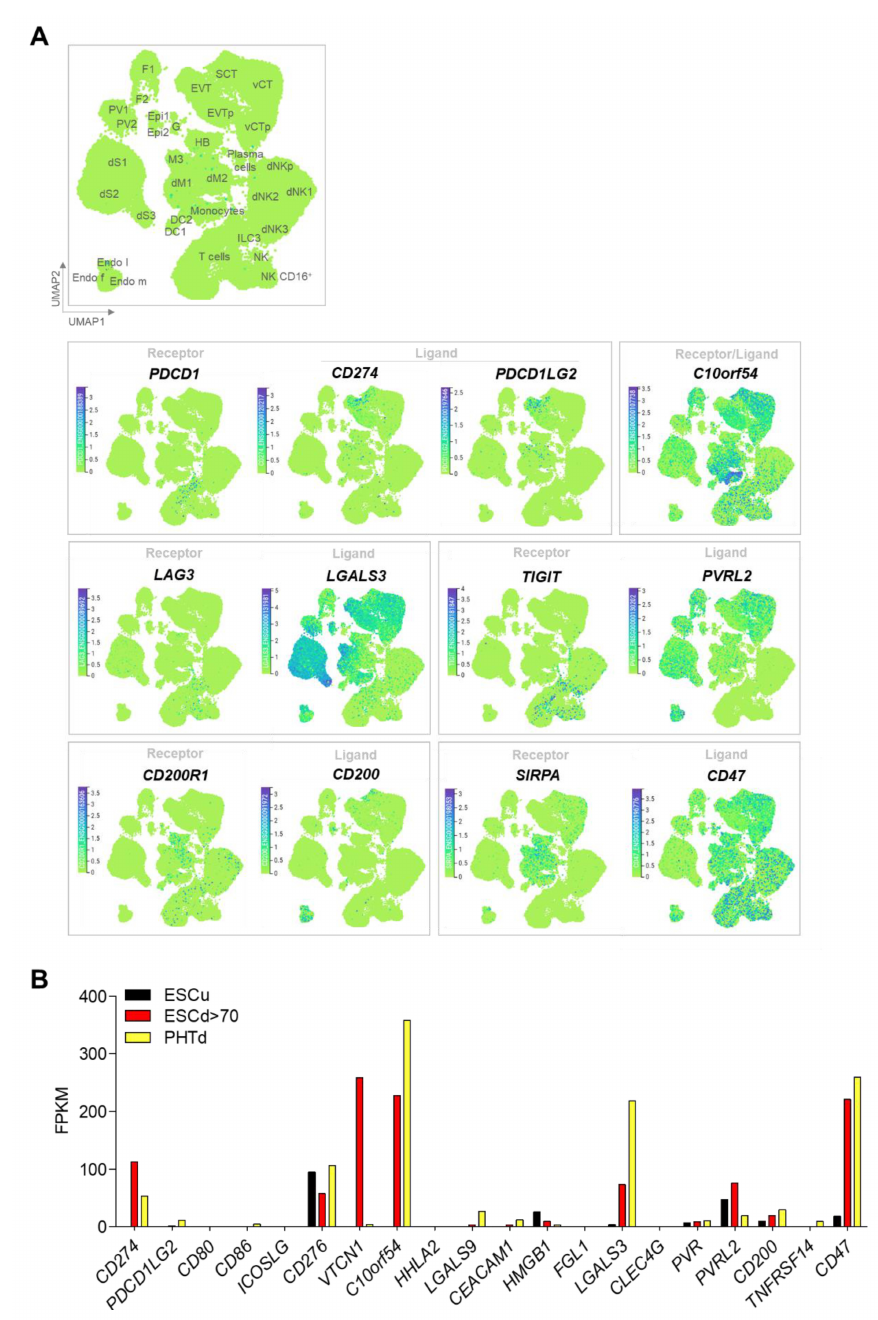
Figure 2. Expression of inhibitory immune checkpoints. ( A ) Uniform manifold Approximation and Projection (UMAP) visualization of the log-transformed, normalized expression of immune checkpoint receptors and ligands in placental and decidual cell clusters of the first trimester. Data are available online at http://data.teichlab.org (maternal–fetal interface) (accessed on 11 November 2018) as provided by Vento-Tormo et al. [58]. DC, dendritic cells; dM, decidual macrophages; dS, decidual stromal cells; Endo, endothelial cells; Epi, epithelial glandular cells; F, fibroblasts; HB, Hofbauer cells; PV, perivascular cells; SCT, syncytiotrophoblast; VCT, villous cytotrophoblast; EVT, extravillous trophoblast; f, fetal; ILC, innate lymphocyte cells; l, lymphatic; m, maternal; p, proliferative; M3, maternal macrophages; G, granulocytes. ( B ) Comparative expression of immune checkpoint inhibitors ligands in undifferentiated H1 ESC (ESCu, black), STB generated from defined DME/F12/KOSR medium that contained BMP4, A83-01, and PD173074 (BAP) treatment-differentiated H1 ESC (ESCd > 70, >70 um size fraction from BAP-differentiated H1 ESC, red), and STB generated from term placenta (PTHd, yellow). Transcript levels are shown in FPKM (Fragments Per Kilobase of transcript per Million mapped reads). RNAseq data are from Yabe et al.